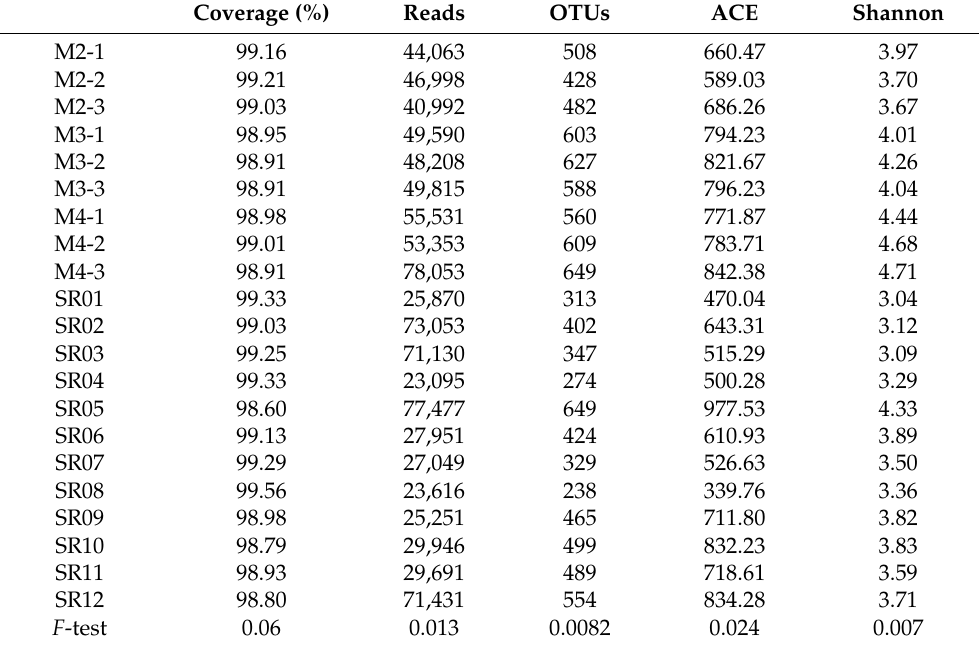
Table 3. Summary information from high-throughput sequencing data for the 21 bacterial